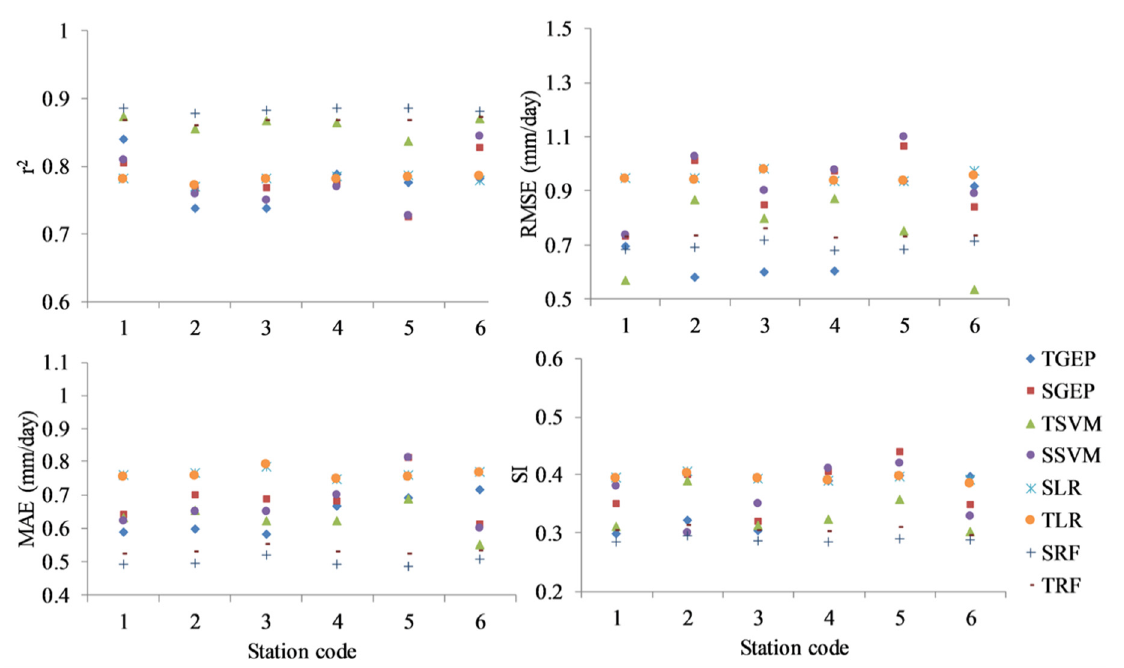
Figure 4. Statistical indices of mass transfer-based combination for the four applied models (GEP, SVM, LR, and RF) with local (T) and spatial (S) approaches.